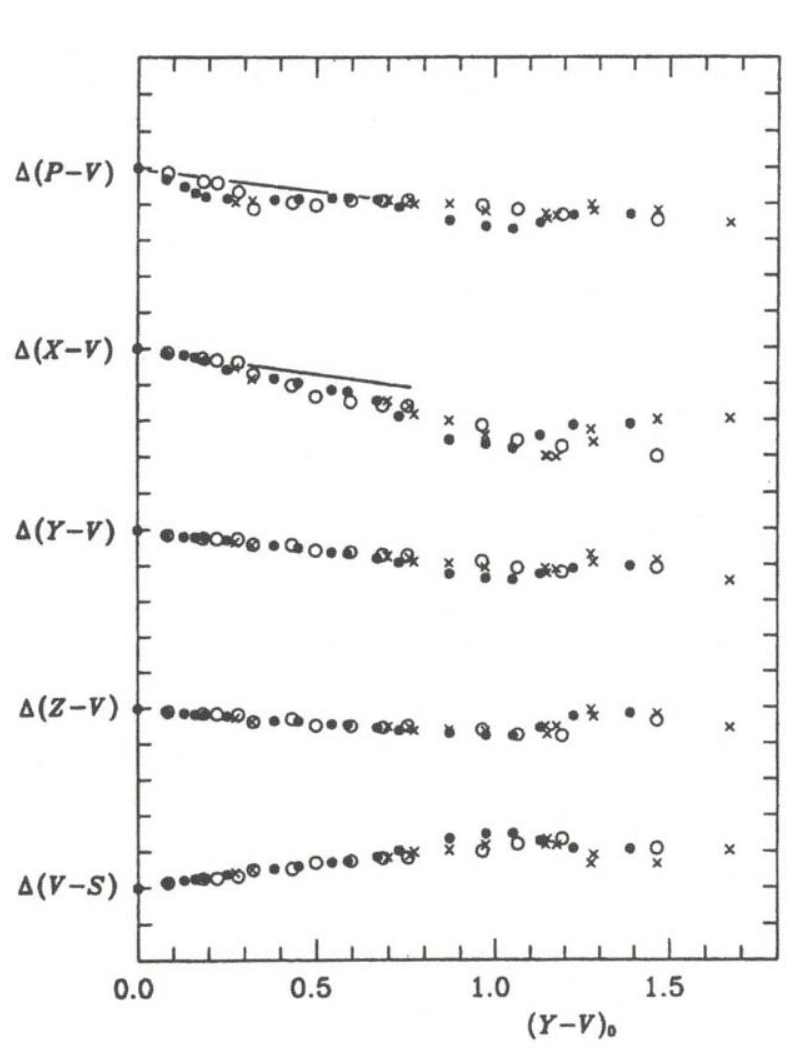
Fig. 2. The computed differences of color indices (standard minus CCD) plotted against Y-V. The P-V color index corresponds to one air- mass ( X — 1.0). Dots are for main sequence stars, crosses are for giants and circles are for supergiants. On both axes the ticks at each 0.1 mag are given. For the P-V and X-V color indices, the reddening line of O-type star is shown. For other color indices, reddening lines run approximately along the sequence of unreddened